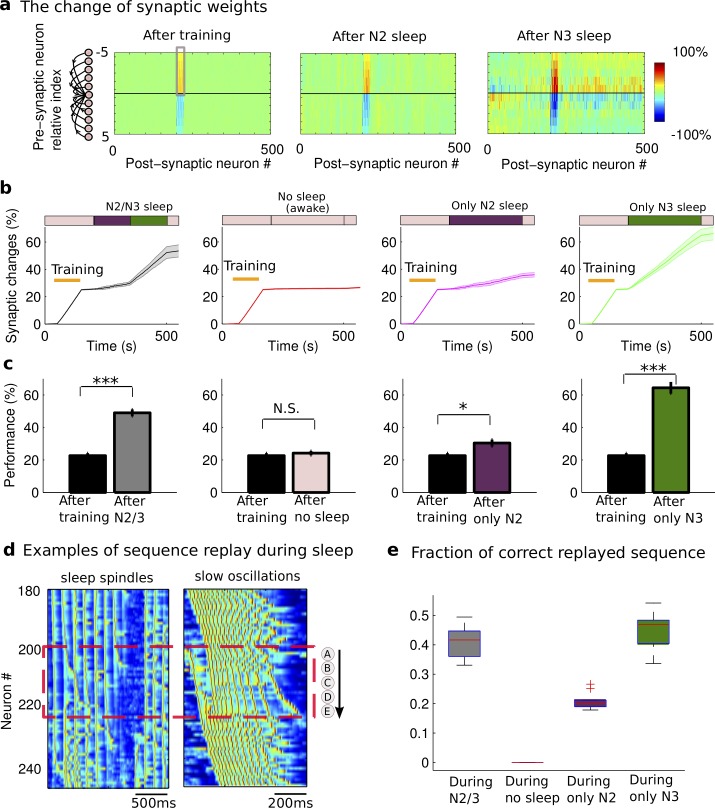
Spontaneous sequence replay mediates synaptic changes underlying memory consolidation during sleep.a) The change of synaptic weights relative to the initial values after training (left), N2 (middle) and N3 sleep (right). The synaptic weights between neurons in direction of sequence activation (grey box) were enhanced due to the sequence replay. b) The dynamics of the mean synaptic weights (grey box in a) shows the progressive increase in synaptic strength during normal N2+N3 sleep (left), only N2 sleep (middle right); only N3 sleep (right). Note the lack of synaptic changes when sleep was supplemented by awake state of the same duration (middle left). Orange bar represents training period. The blocks in the top summarize the protocol of each experiment: Pink block—awake, purple block—N2 sleep, dark green block—N3 sleep. The patch error bar represents standard deviation. c) The bar plots of performance during test sessions after training (before sleep) and after sleep in four different experimental conditions corresponding to b. Error bars indicate SEM. * p<0.05, ** p<0.01, *** p<0.001. N.S. represents no significant difference. d) Characteristic examples of sequence (“ABCDE”) replay during sleep spindles and slow oscillations. e) The fraction of correct replayed sequence (“ABCDE”) during four difference experimental protocols. For the boxplot in the right panel, the central mark indicates the median, and the bottom and top edges of the box indicate the 25th and 75th percentiles, respectively.